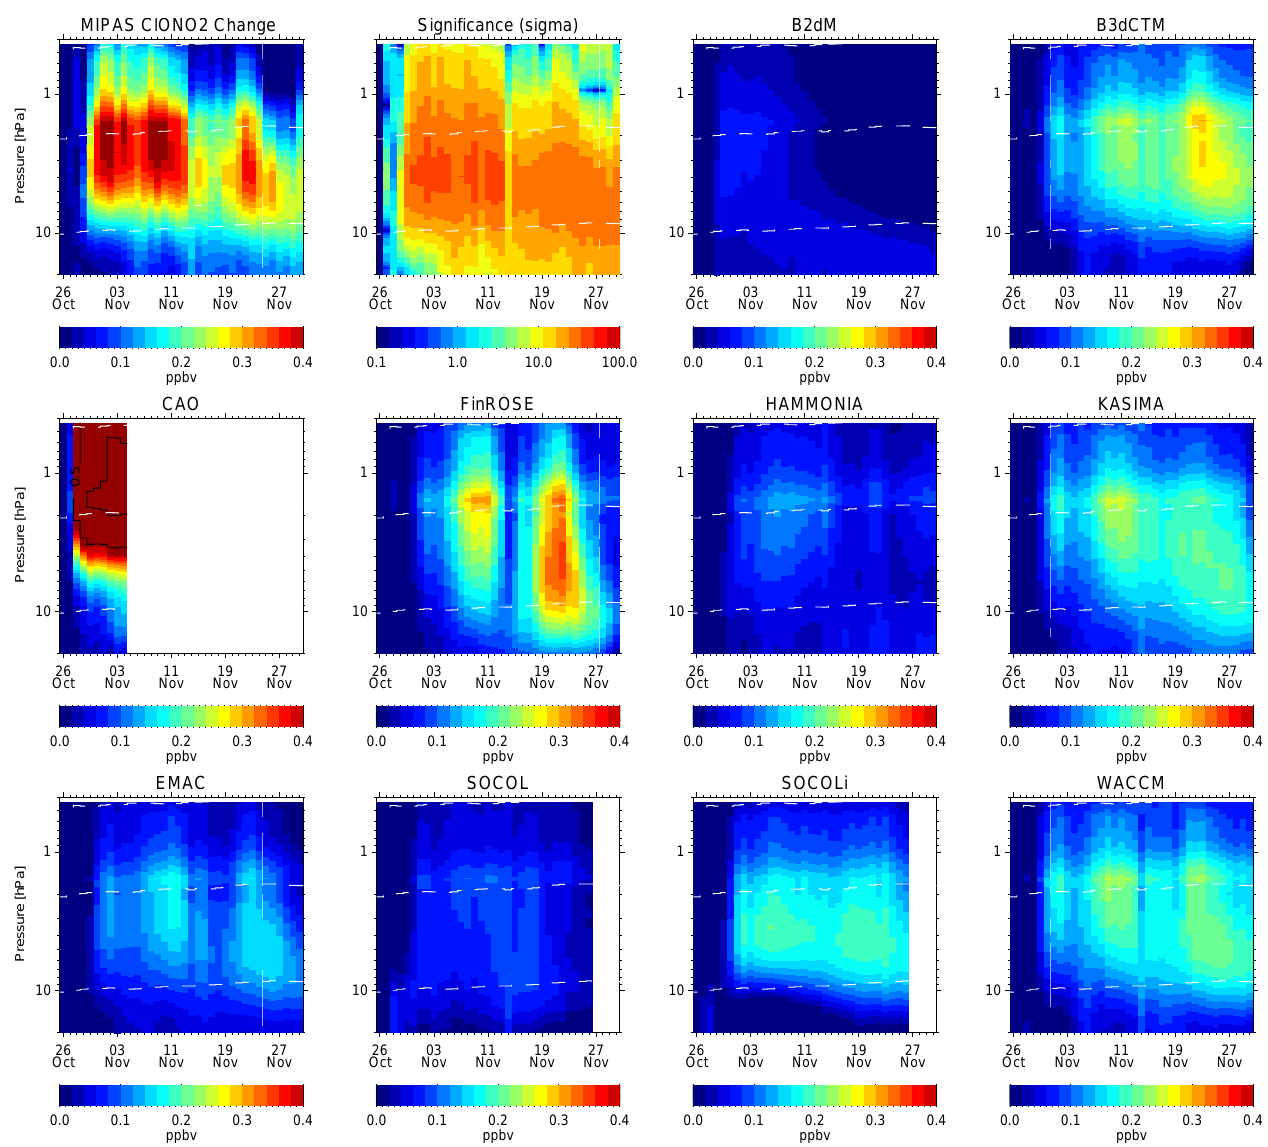
Fig. 36. Temporal evolution of area-weighted averages of relative ClONO 2 changes with respect to 26 October 2003 in MIPAS observations and model simulations at 70–90 ◦ N, as well as differences between modeled and observed averages. Contour lines reflect 0.5ppbv steps. The significance of observed ClONO 2 changes (in units of σ ) is shown in the upper second panel (from the left).